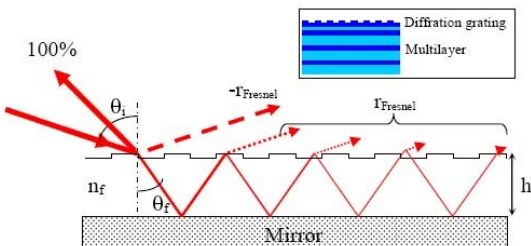
Figure 10. Fresnel reflection mechanism on a mirror-based corrugated dielectric film: direct reflection, field trapping, leaky-mode propagation, and re-radiation. The corrugation balances the direct-reflected and re-radiated field moduli, ensuring 100% − 1st-order efficiency. The inset represents the fabricated multilayer-grating